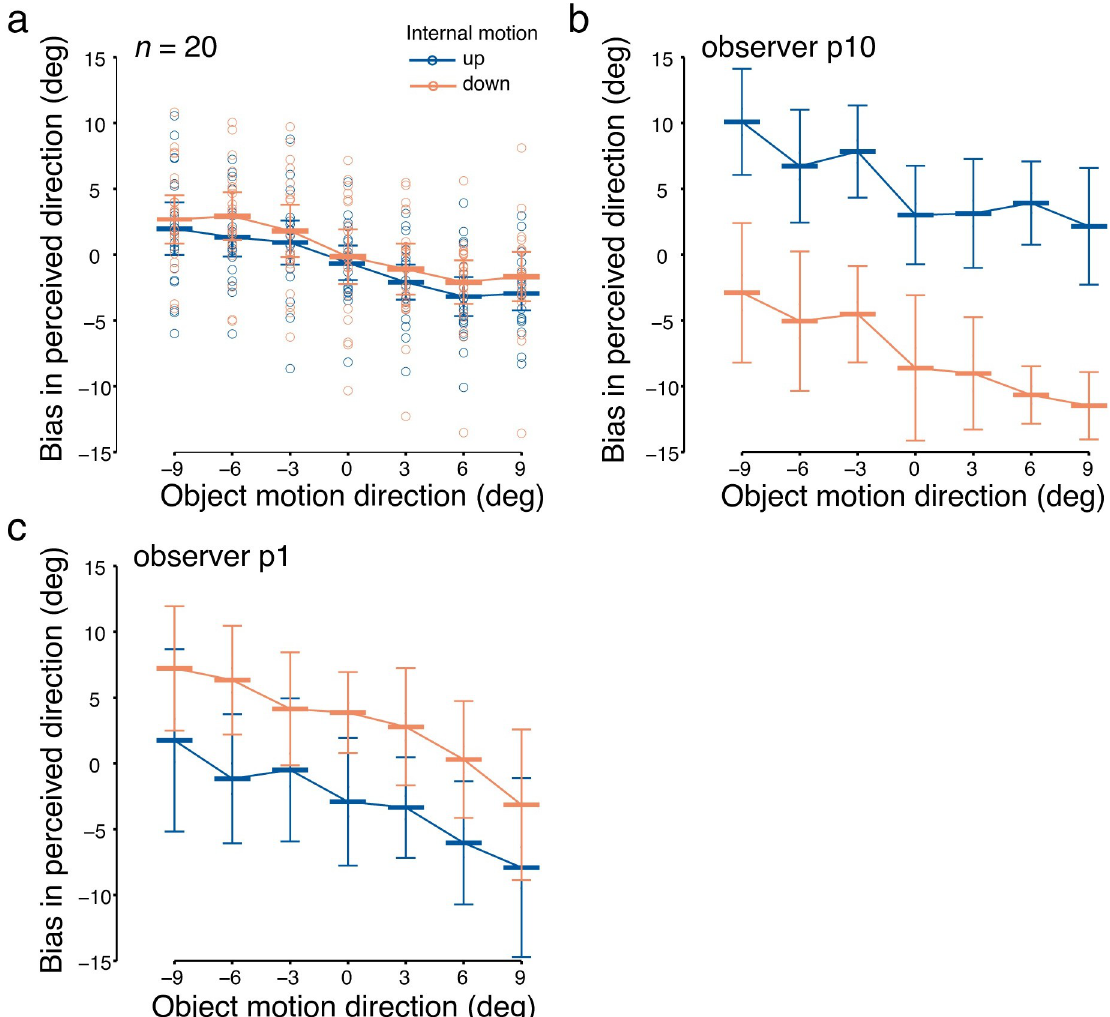
Fig 6. Biases in perceived direction in conditions with internal motion. (a) Bias in perceived direction averaged across all observers. Horizontal bars indicate the mean across observers, and error bars indicate the 95% CI. The following panels show examples of individual data showing (b) assimilation bias or (c) contrast bias in perception. Horizontal bars indicate the mean perceived direction bias across trials, and error bars indicate the standard deviation.